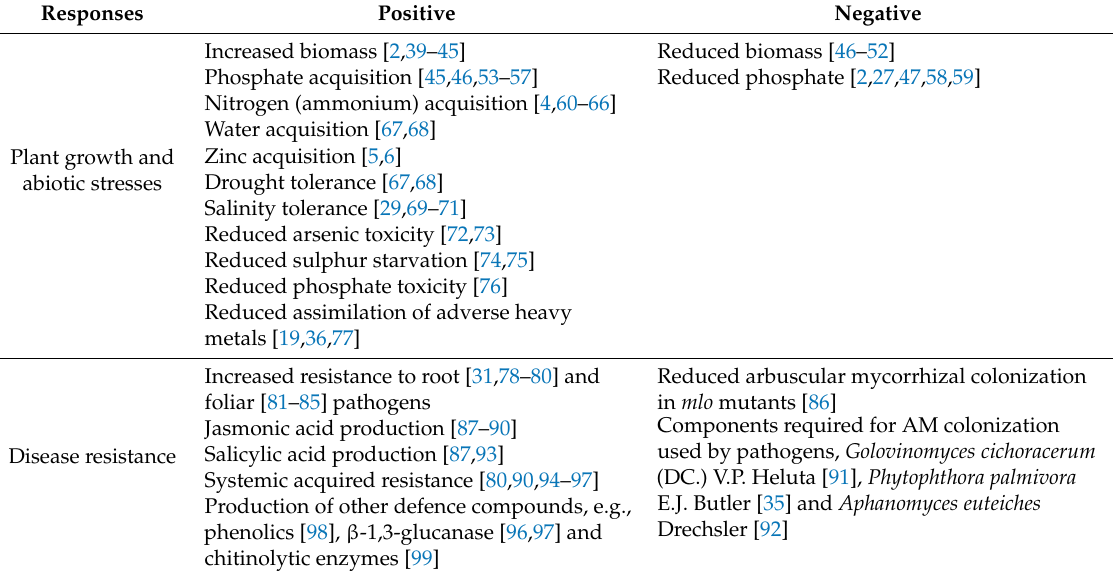
Table 1. Summary of the positive and negative effects reported to be associated with arbuscular mycorrhizal (AM)